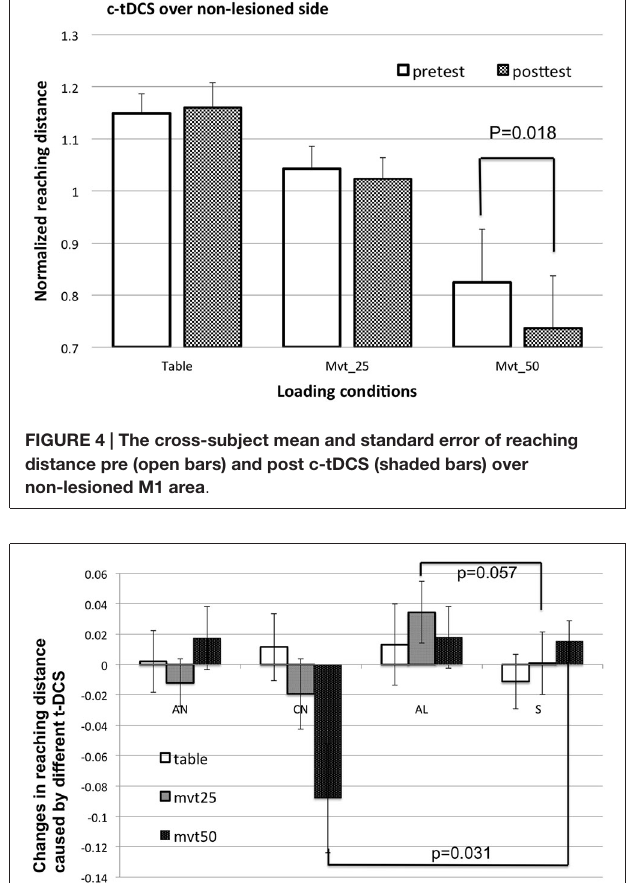
FIGURE 5 | The cross-subject mean and standard deviation of normalized tDCS-induced changes in reaching distance (i.e., (post-tDCS reaching distance − pre-tDCS reaching distance)/(pre-tDCS reaching distance)) with different SABD loadings . In this figure, AN, CN, AL, and S mean a-tDCS of non-lesioned side, c-tDCS of non-lesioned side, a-tDCS of lesioned side and sham stimulation,